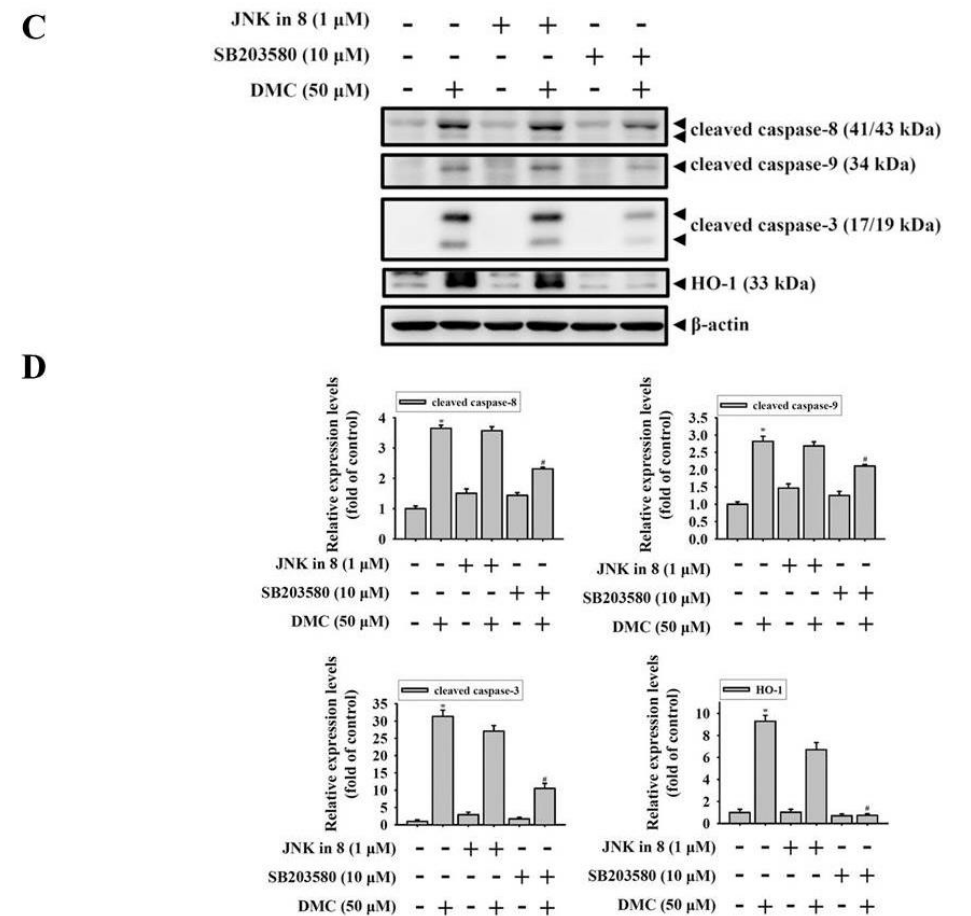
Figure 5. The p38 mitogen-activated protein kinase (MAPK) pathway is involved in the demethoxycurcumin (DMC)-mediated induction of heme oxygenase (HO)-1 expression and cell apoptosis. ( A and B ) HSC-3 cells were exposed to the vehicle or DMC (12.5–50 μM) for 24 h; then, the phosphorylation status of extracellular signal-regulated kinase (ERK)1/2, c-Jun N-terminal kinase (JNK)1/2, and p38 were analyzed by Western blot analysis ( A ). Quantitative results of phospho- MAPKs, which were adjusted to total MAPKs and are expressed as multiples of induction beyond each respective control ( B ). Data are presented as the mean ± SD from three independent experiments. * p < 0.05, compared to the vehicle group. ( C and D ) HSC-3 cells were pretreated with SB203580 (10 μM) or c-Jun N-terminal kinase (JNK)-in-8 (1 μM) for 1 h followed by another 24-h vehicle or